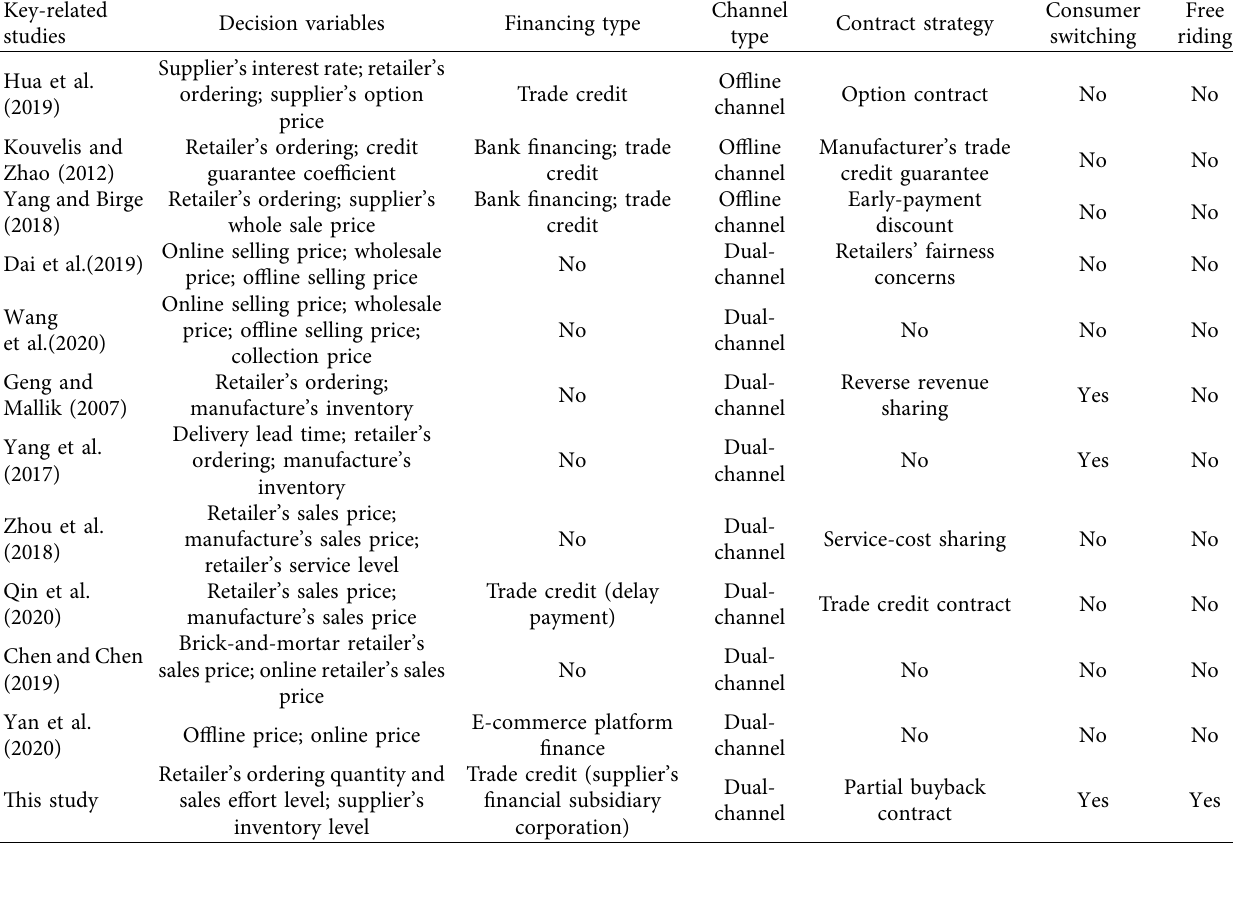
Table 1: List of key-related